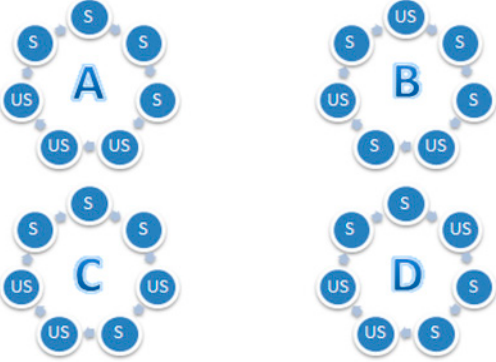
Figure 8. Types (A,B,C, and D) of substituted β -CD / PCL isomers: The blue circle represents the glucopyranose unit; S, substituted by the PCL; US, unsubstituted by the PCL.